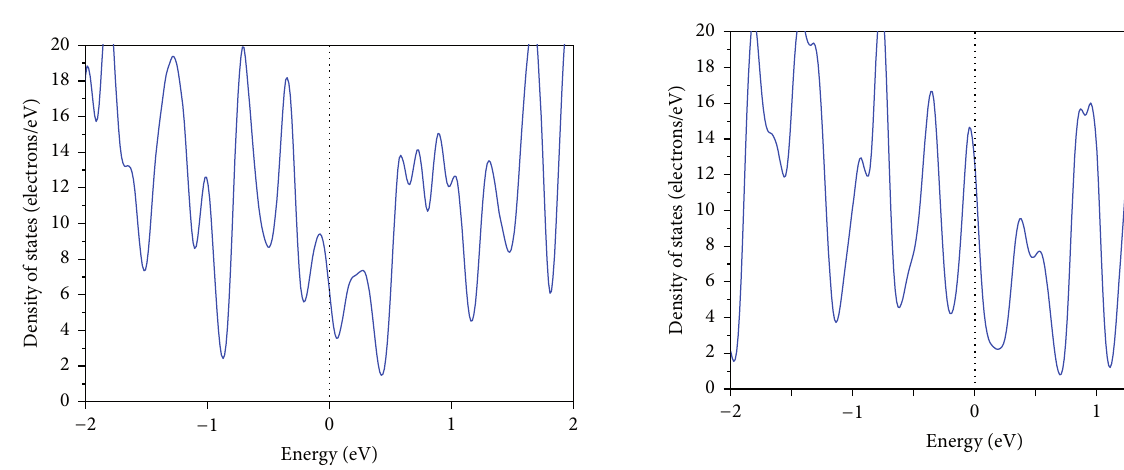
Figure 12: Density of states (DOS) of N1-doped single walled chiral (4,2) BNT. The Fermi energy is set corresponding to zero energy and represented by dotted line.